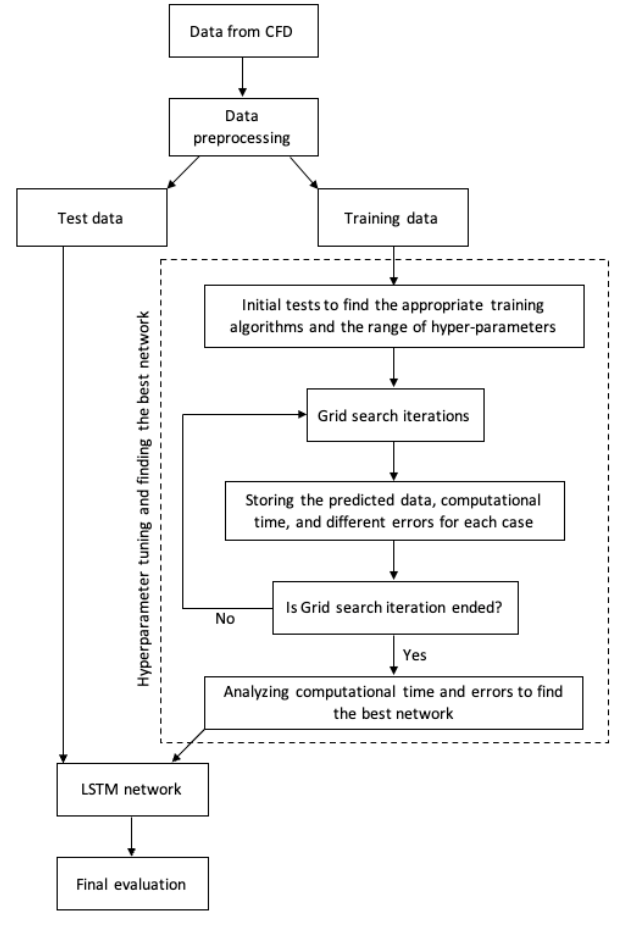
Figure 5. A generalized algorithm for the development of an ANN-based